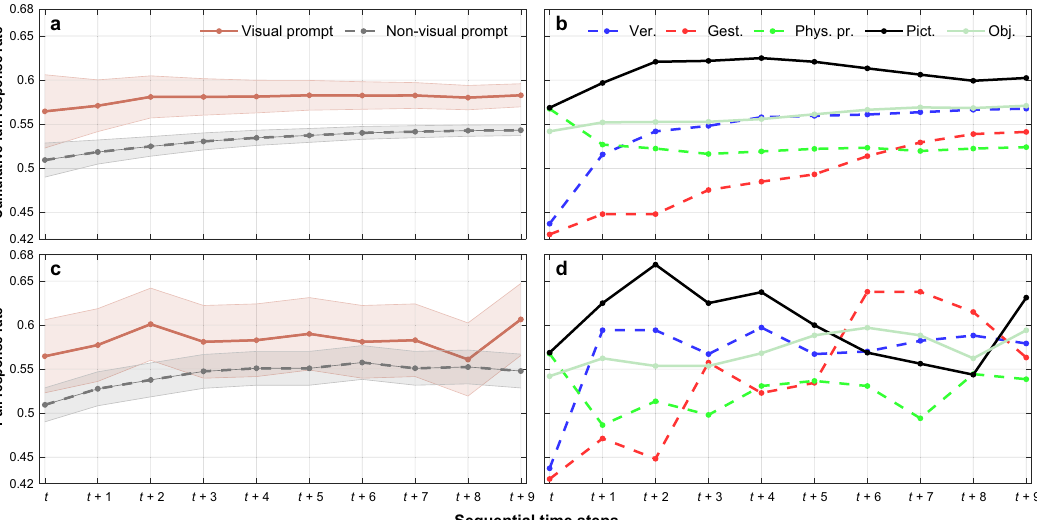
Fig. 1 Long-term effects of teacher communication strategies. a Cumulative student full response rate with 95% con fi dence intervals (shaded) across a sequence of consecutive teacher communications, where the fi rst one is a visual prompt (solid line) or a non-visual prompt communication strategy (dashed line); b Cumulative student full response rate across a sequence of consecutive teacher communications, for all possible fi rst teacher communication strategy options; c Student full response rate with 95% con fi dence intervals (shaded) for all points within a sequence of consecutive teacher communications, where the fi rst one is a visual prompt or a non visual prompt communication strategy; d Student full response rate for all points within a sequence of consecutive teacher communications, for all possible fi rst teacher communication strategy options. For both ( a ) and ( b ), the averaging is progressive as new data points become available (cumulative) and thus, it is expected to converge to the actual average full response rate in the data (56.59%). In contrast, for both ( c ) and ( d ), the averaging is focused on each single sequence point and thus, it is not expected to converge to a certain quantity.